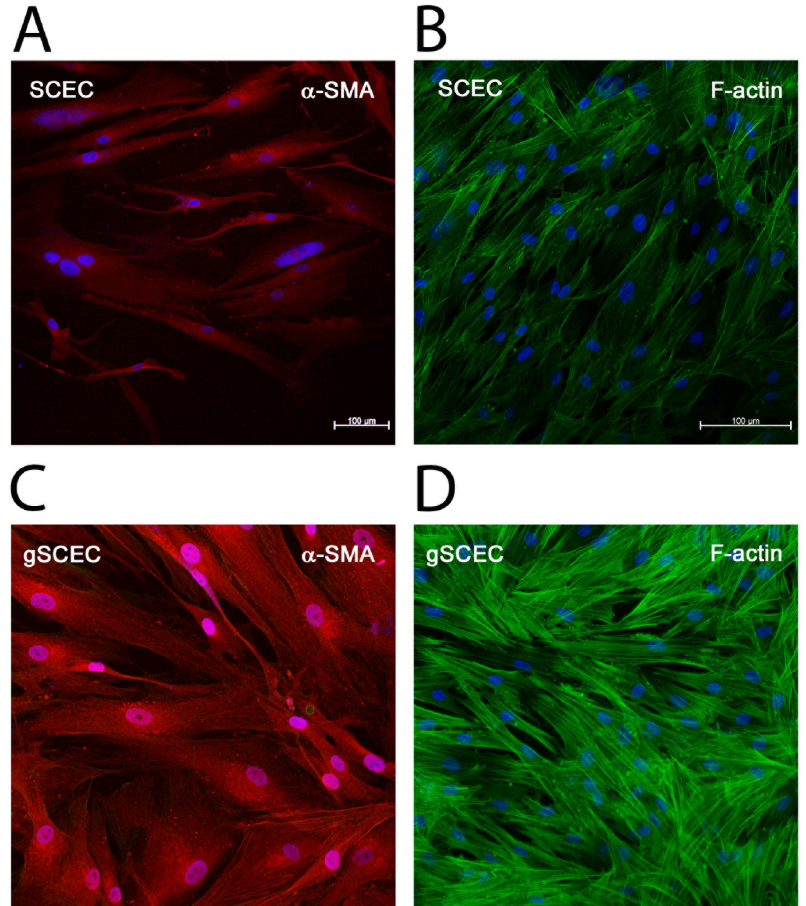
Figure 3. Elevated levels of α -SMA and F-actin protein in glaucomatous SCECs, compared to healthy SCECs. Increased expressions of cytoskeletal proteins α -SMA (red) and F-actin (green) were observed in gSCECs ( C + D ), compared to healthy SCECs ( A + B ). gSCECs appeared to be larger in size and showed increased expression of α -SMA ( C ), compared to healthy SCECs ( A ). An increase in actin stress fibres and the density of F-actin cytoskeletal protein expression was apparent in gSCECs ( D ), compared to healthy SCECs ( B ). These cells were seeded at the same time and at the same density; however, gSCECs appeared more confluent ( C + D ) than healthy SCECs ( A + B ). DAPI is represented in blue. Scale bar represents 100 µ m. SCEC 89 and gSCEC 90 above represent n = 3 cell strains analysed for both gSCECs and healthy